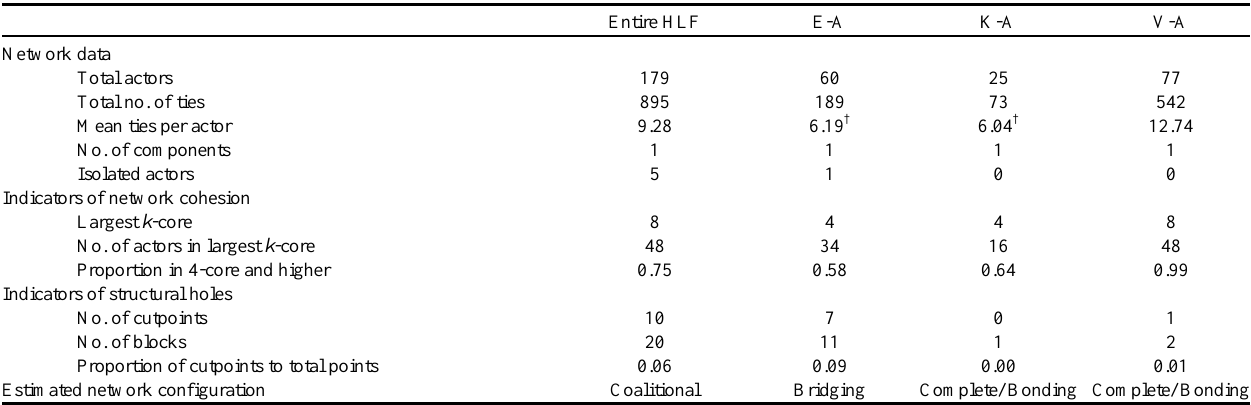
Table 1 . Summary of group level network characteristics.